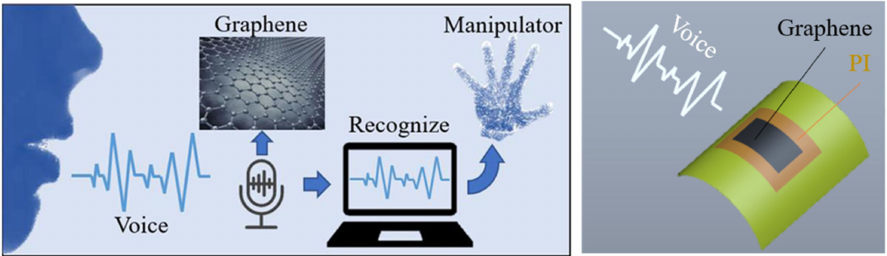
Figure 12. The intelligent speech recognition and motion control system. Reproduced with permission from [18]. Copyright 2022 American Chemical